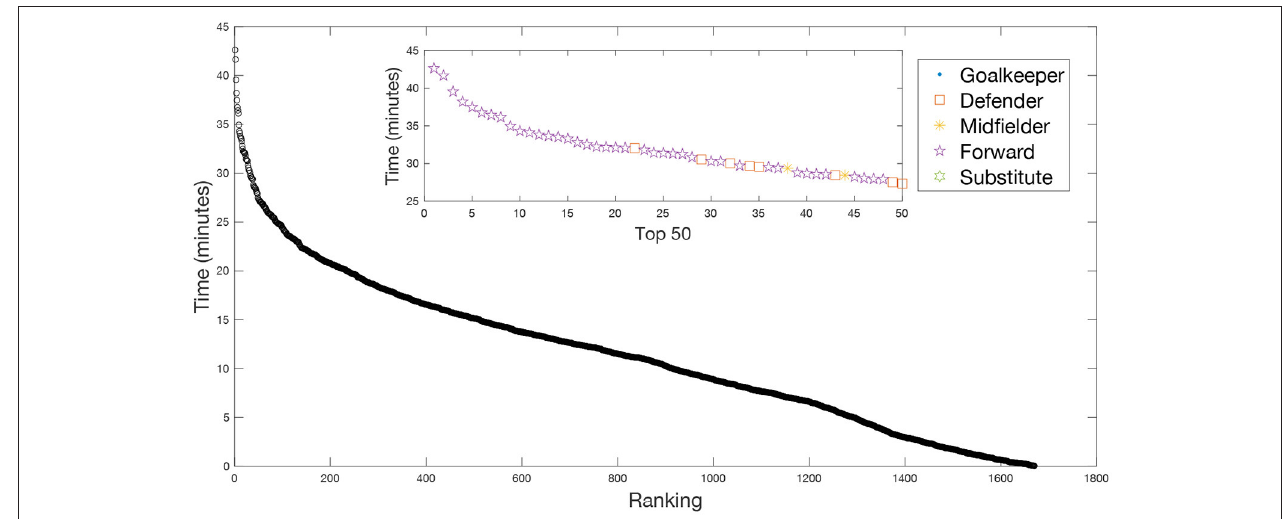
FIGURE 3 | Heterogeneity of the contact time. Ranking of the aggregated time t aggr of each player from all his rivals during a whole match. Each point accounts for the total time a player has been with at least one opponent closer than a distance D = 2 m. The inset shows the aggregated time of players at the top 50. We can observe that the ranking is leaded by forwards. Only eight defenders and two midfielders appear in the top 50, all of them beyond the 20th position.